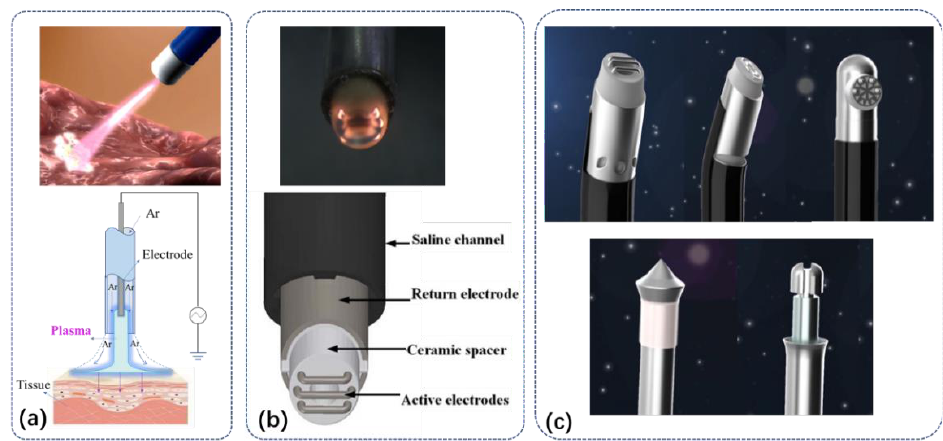
Figure 1. The structure and working diagram of a typical plasma scalpel. ( a ) Argon plasma coagulation (APC) with one power electrode inside the argon flow tube and the other distal ground electrode. ( b ) The plasma scalpel with the power and ground electrode inside the operation handle generates plasma in the saline. ( c ) Various plasma scalpels manufactured by Jiangsu Bonss Medical Technology Co., Ltd (Taizhou, China).